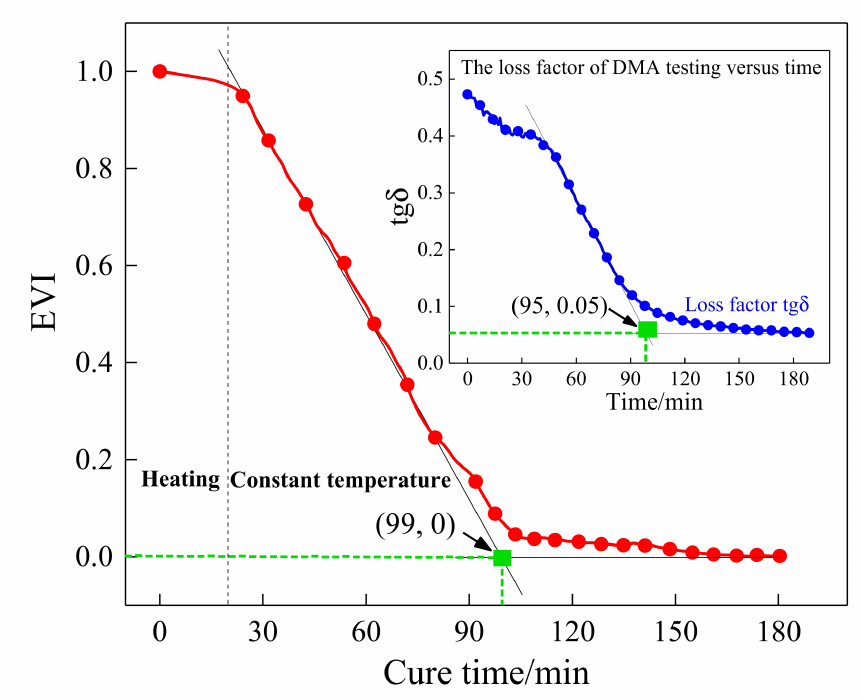
Figure 13. The EVI curve of the sensing path P4s_6s for the quasi-isotropic